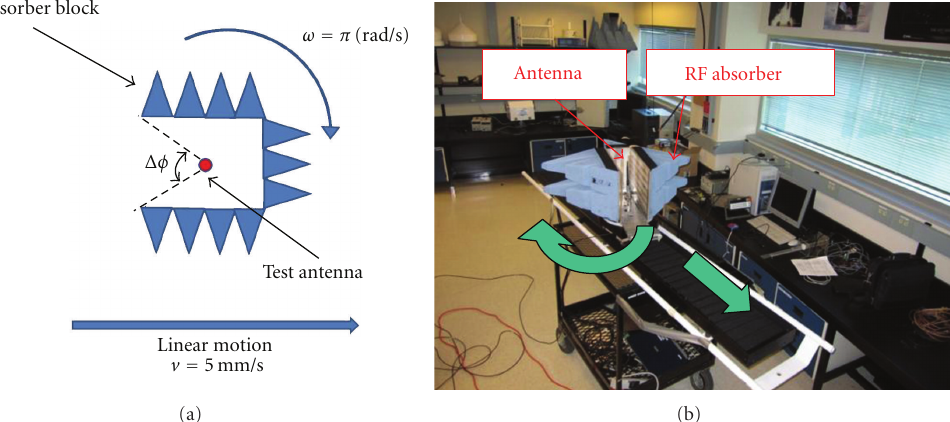
Figure 2: (a) The arrangement of the absorber block and the antenna in the tests, as seen from the top. The antenna is colocated with the axis of rotation of the absorber block. The height of the absorber block is such that it blocks the direct path signals in the elevation range of | θ | <π/ 4. (b) The measurement equipment.